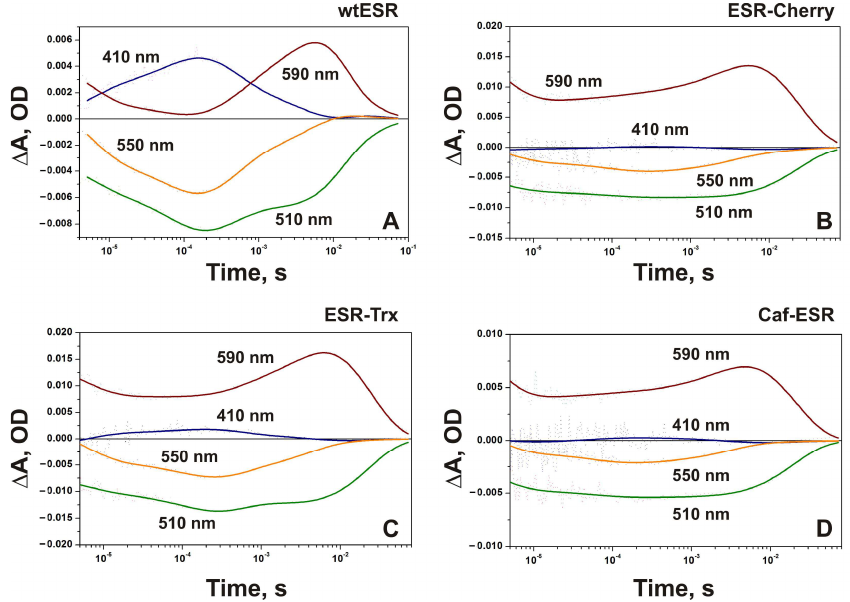
Figure 3. Light-induced absorption changes at four characteristic wavelengths (410 nm, 590 nm, 550 nm, and 510 nm) at pH 7.5 in proteoliposome suspensions containing: ( A ) wild-type ESR; ( B ) ESR-Cherry; ( C ) ESR-Trx; ( D ) Caf-ESR.